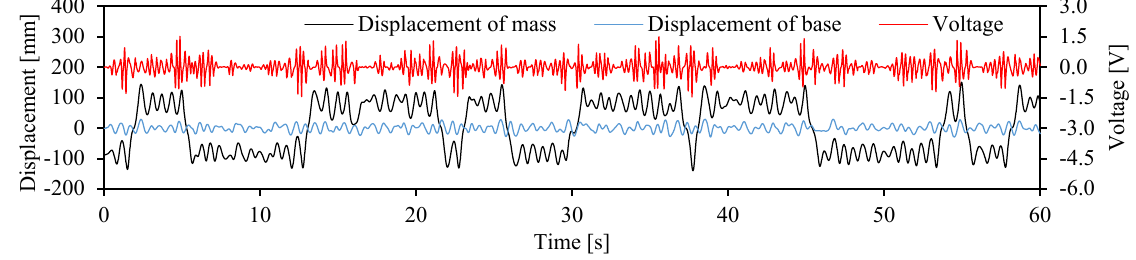
The number of occurrences of bi-stable vibration in the mass block began decreasing